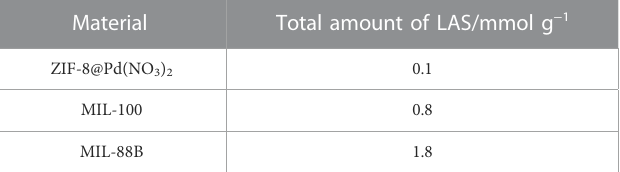
TABLE 4 Experimental acid site equivalence by pyridine adsorption.